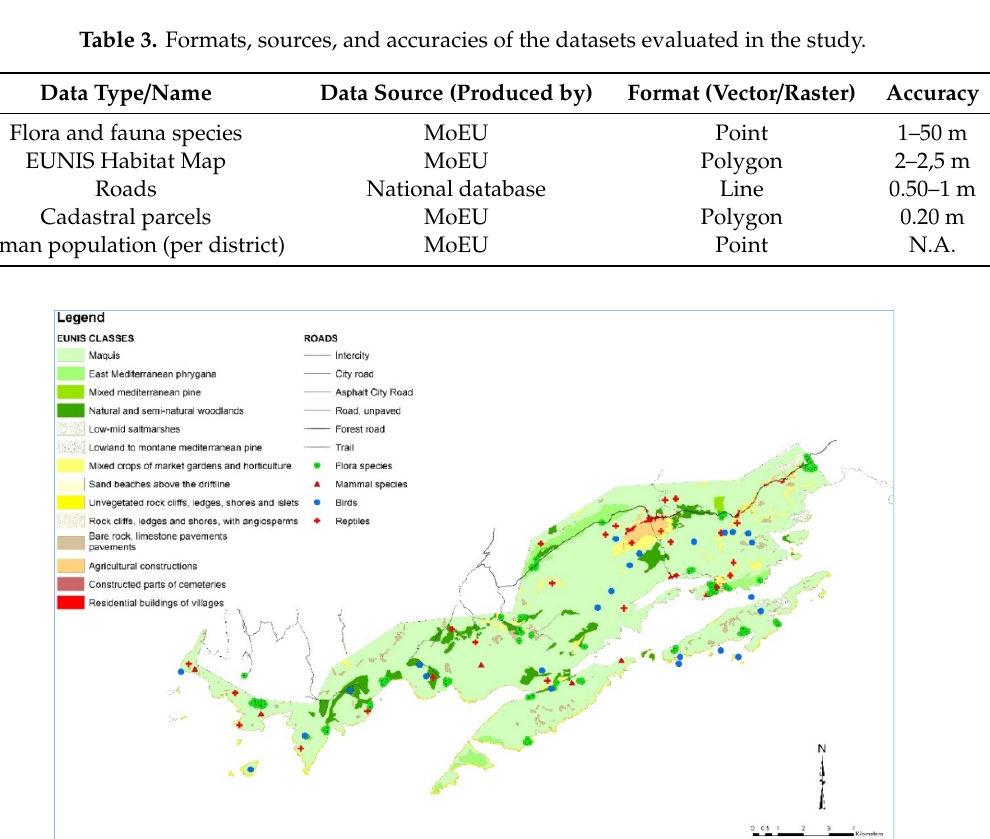
Table 2. EUNIS Habitat types in Kas-Kekova PA [36].